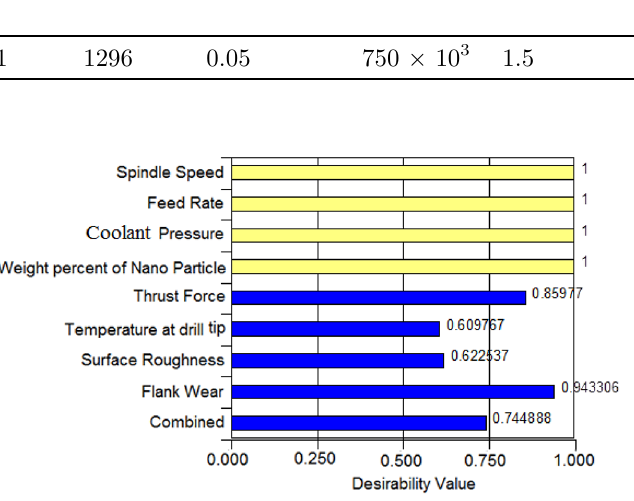
Fig. 16. Histogram of desirability for the best